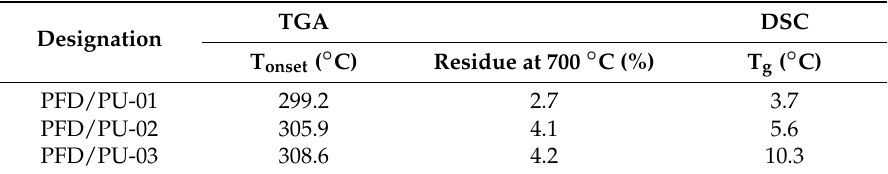
Figure 13. TGA and DTG curves of PFD/PUs. Table 4. Thermal properties of PFD/PUs. TGA, thermogravimetric analysis; DSC, differential scanning